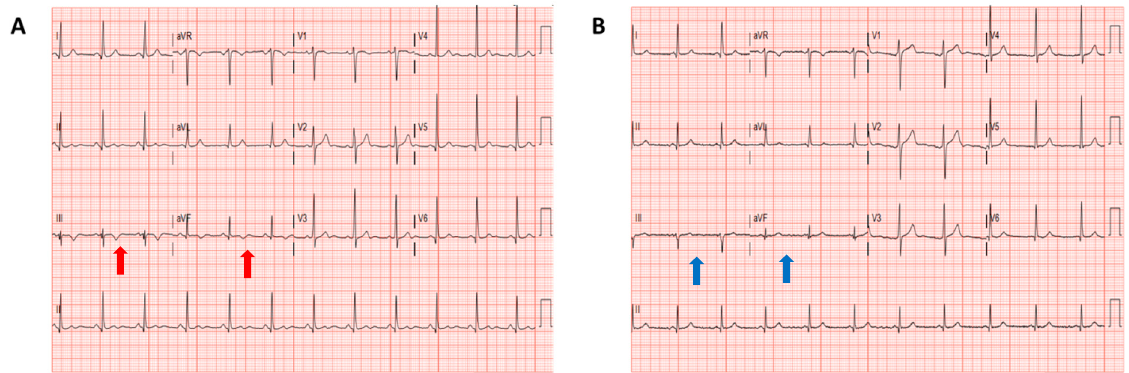
Figure 1. Comparison of electrocardiogram (ECG) before and after mitral valve repair. Panel ( A ): ECG during hospitalization, showing T wave inversion on lead III, AVF (red arrows). Panel ( B ): ECG after mitral valve repair, showing normalization of the T wave changes (blue arrows).